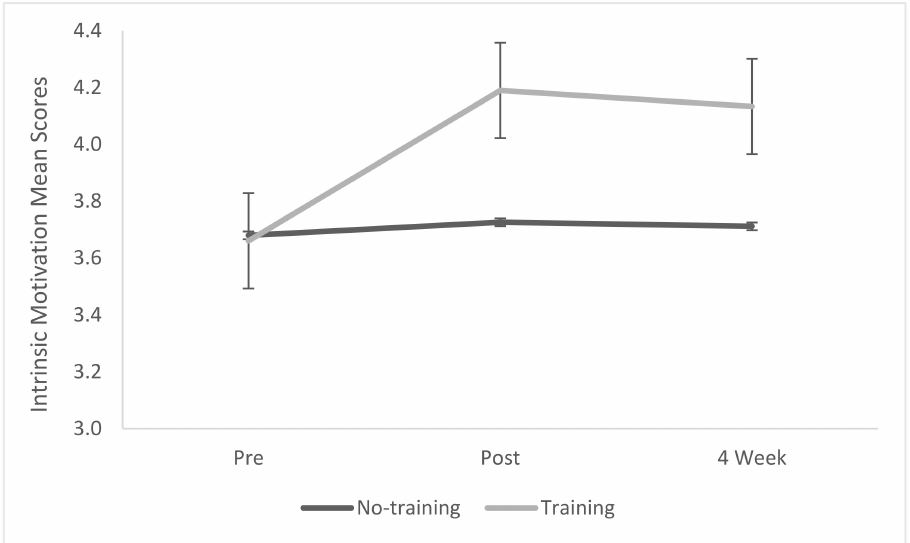
Figure 1. Intrinsic Motivation Inventory mean score.